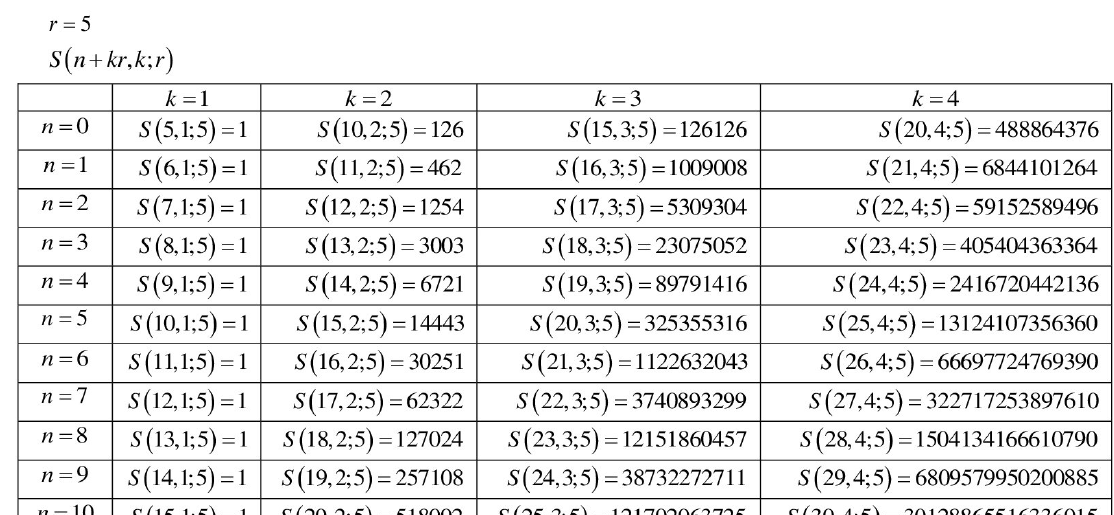
Figure 7. Numbers S ( n + 4 k , k ;4 ) , k = 1,2,3,4; n = 1,2, . . . ,10.